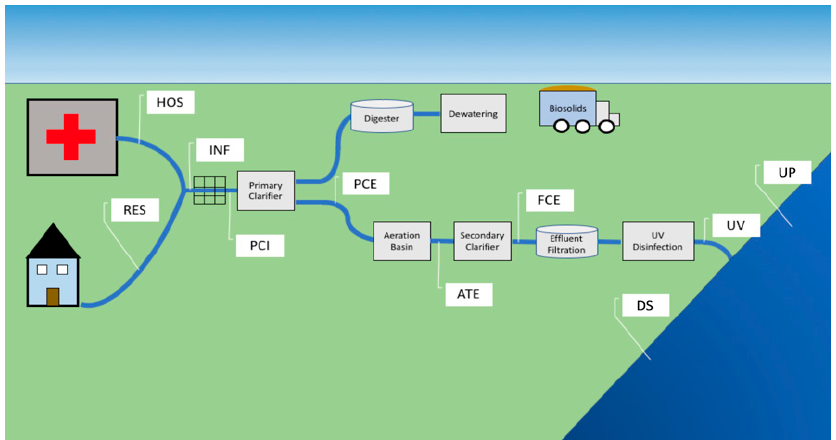
Figure 1. Schematic of the wastewater treatment process and sampling sites utilized for this study. Raw sewage from residential (RES) and hospital (HOS) sources are routed to a main sewer line. The combined raw influent (INF) is then passed through a physical screen to filter out large solids. The screen-filtered wastewater (PCI) undergoes primary clarification. The primary clarifier effluent (PCE) is routed to an aeration basin for biological nutrient removal. The aeration tank effluent (ATE) then undergoes a secondary clarification process. The final clarification effluent (FCE) undergoes a final filtration step before UV treatment (UV) for microbial disinfection prior to stream release. The large solids removed during primary clarification are routed to a digester and dewatered for the production of biosolids. (Downstream, DS; Upstream, UP).